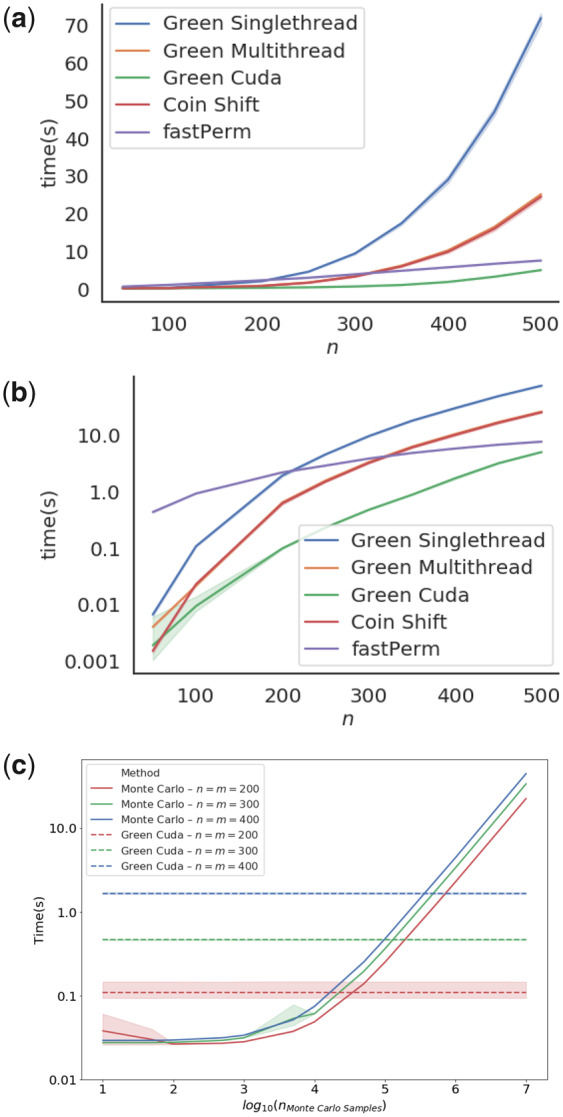
Running time requirements of the compared algorithms. We plotted the time required to calculate P values for samples from yA∼U(0,n) and yB∼U(0,n) for different sample sizes n. The mean time and the 95% confidence interval around the mean time to calculate each of 5 replicate samplings was plotted in (a) linear and (b) log scale. It should be noted that the execution times where highly reproducible, and it might be hard to see the confidence interval in the plots. (c) We further investigated the running time as a function of the number of Monte Carlo samples for a MC-based approach. We compared running time for a Monte Carlo sampled to draw samples of |yiA|=|yiB|=m=n∈[200,300,400], with five replicates. The horizontal lines represent the running time for Green Cuda to compute the same samples